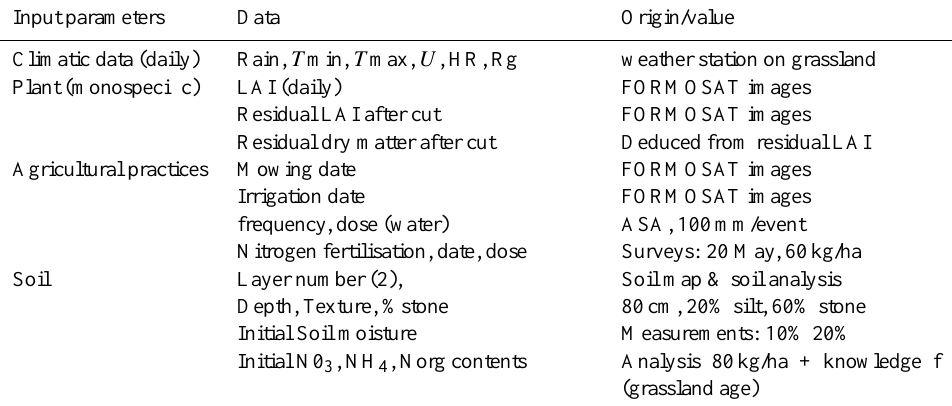
Figure 5 . Relationship obtained between the 1rst mowing date and the irrigation date just after the mowing, for the different grasslands surveyed over the Crau region.